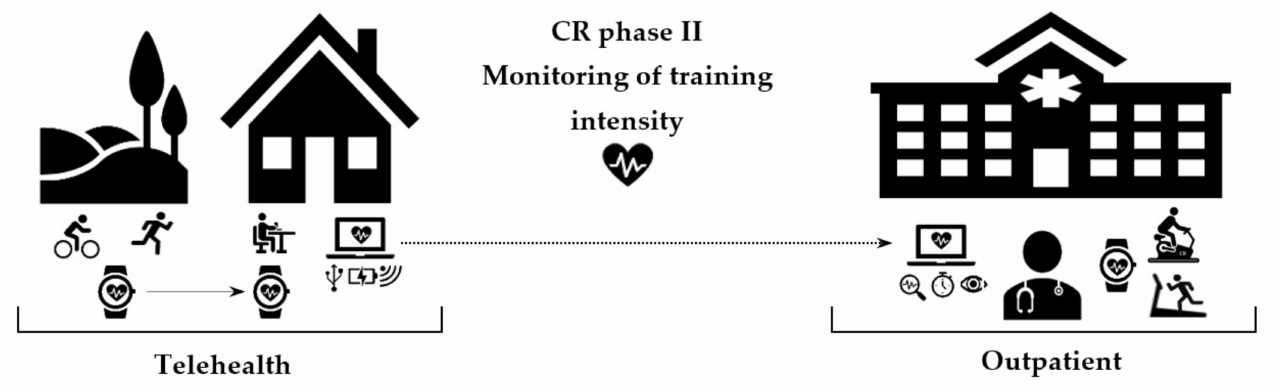
Figure 2. Scheme of monitoring training